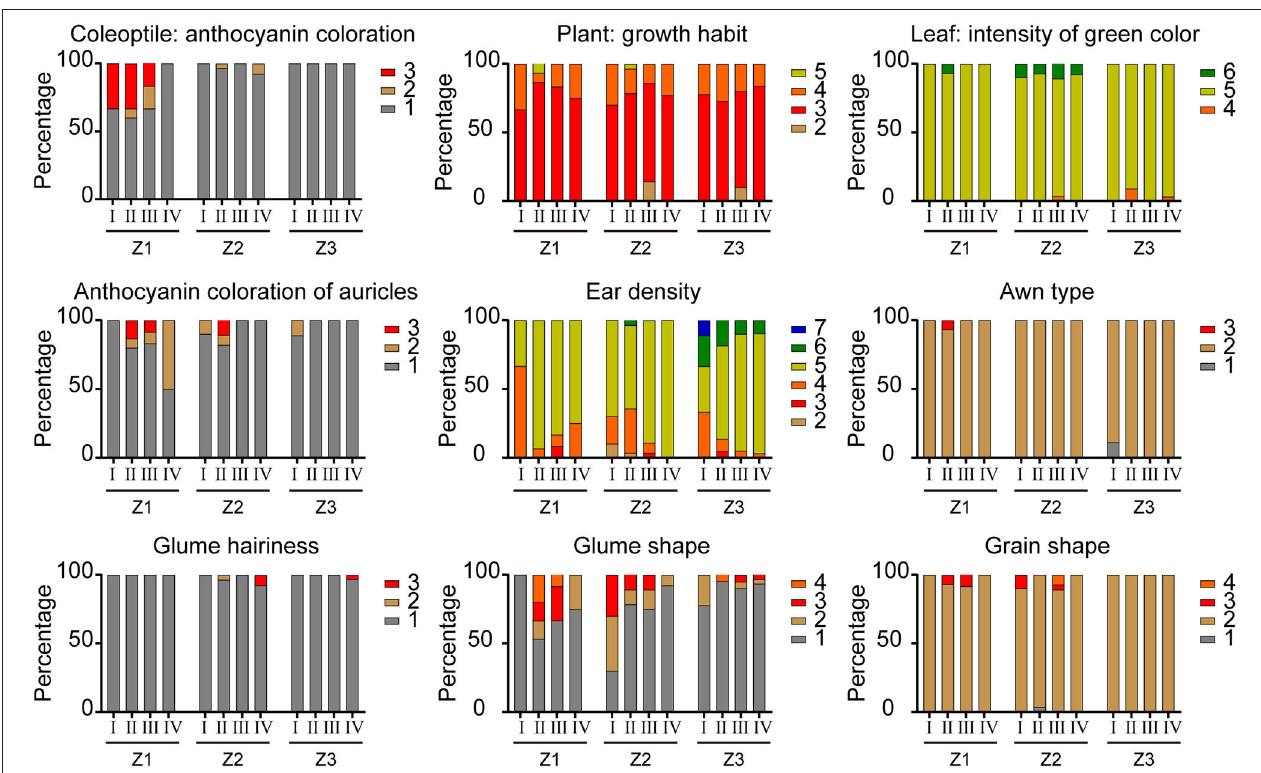
FIGURE 2 | Changes in nine visually assessed characteristics of wheat varieties with the first artificial selection trend. Roman numerals I, II, III and IV refer to different groups according to the approved time. The rest of the legends have the same meaning as in Figure 1 .